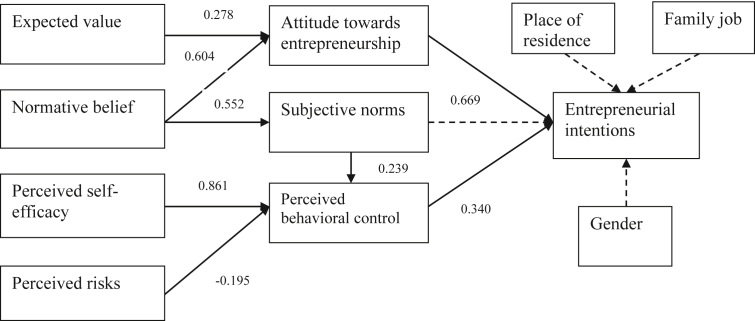
The relationship between the constructs in the model of business students sample. Notes: Dotted lines are not statistically significant.